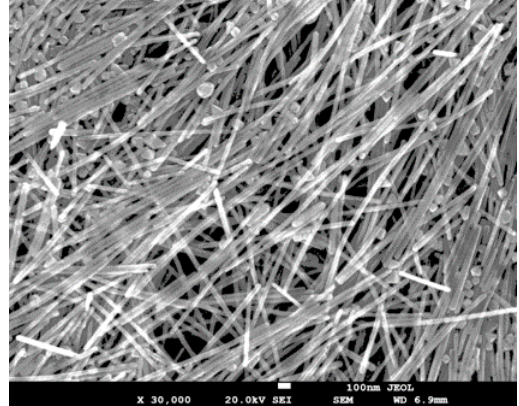
Figure 2. Morphology of the